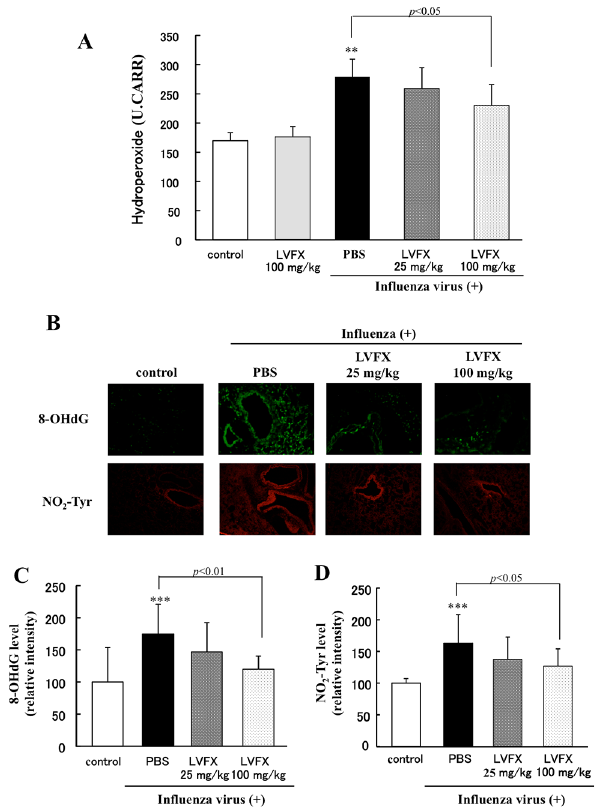
Fig 4. The effect of LVFX on oxidative stress in influenza virus-infected mice. The effect of LVFX on the accumulation of oxidative stress in the blood or lungs were determined (A) by measuring hydroperoxide levels (dROMs test) or (B) immunostaining for 8-OHdG (upper panel) and NO 2 -Tyr (lower panel) level at the day 7 after influenza virus infection. The fluorescence intensity of (C) 8-OHdG and (D) NO 2 -Tyr were quantified by the imageJ software. Each bar represents the mean ± SD (n = 5 – 9). ** p < 0.01, *** p < 0.001 vs